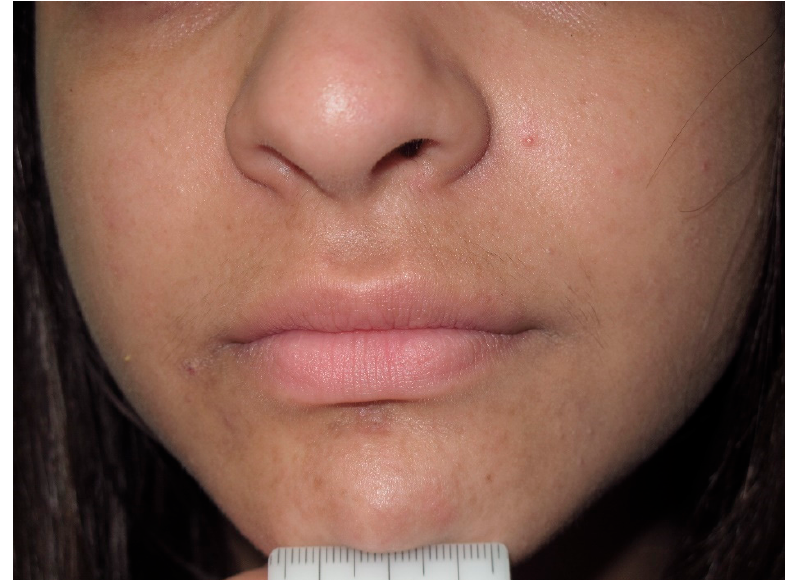
Figure 8. Deep neurofibroma soft of chin.